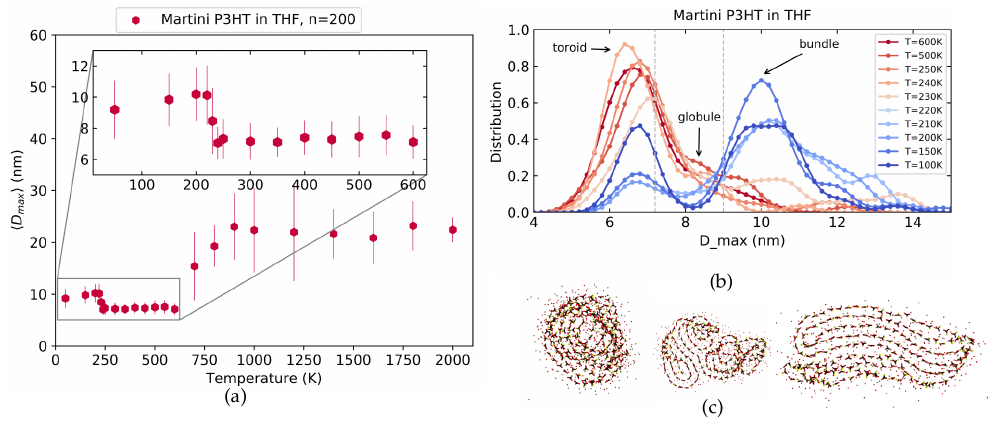
Figure 9. The maximum distance between monomers for the Martini model of P3HT in THF solvent. ( a ) Averaged D max as a function of temperature. ( b ) Distributions at various temperatures. ( c ) Illustration of the corresponding conformations: toroids, tight globules and